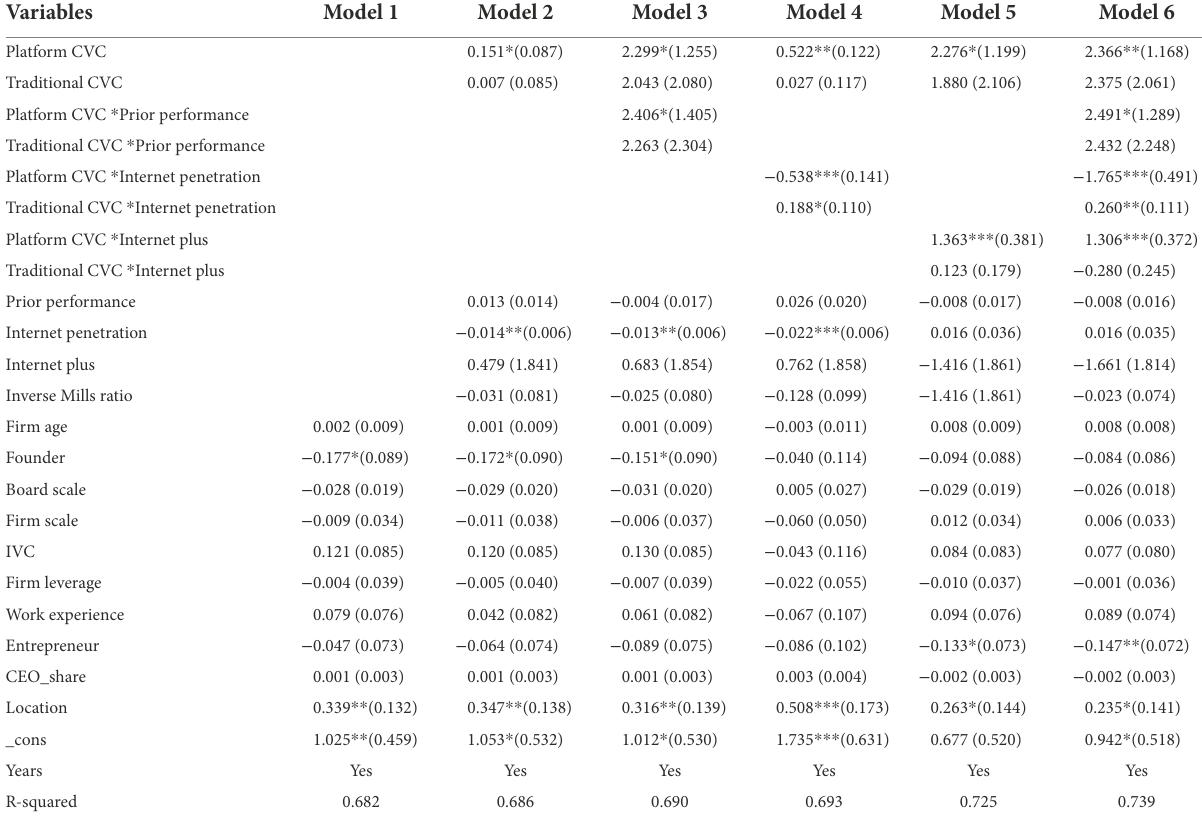
TABLE 1 Regression